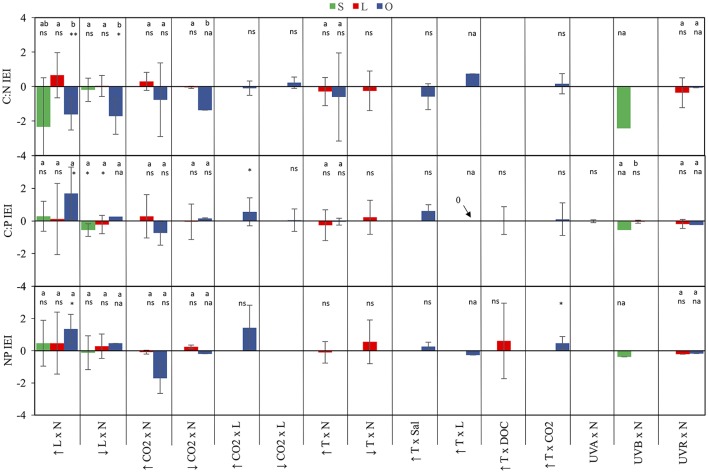
IEI for C:N:P ratios in streams, lakes and oceans. Values represent IEI mean ± 95% confidence intervals (see statistical methods for further detail). Values > 0 indicate a synergistic interaction, values < 0 indicate an antagonistic interaction, and values = 0 indicate the absence of a net interactive effect or the occurrence of an additive effect. Significant differences among systems are denoted by different case letters according to Tuckey's post-hoc comparisons. Below letters and/or symbols are results for one-sample t-test testing IEI differences from the test value = 0 (ns, not significant; na, not applicable with less than two observations; *p < 0.05; **p < 0.01).